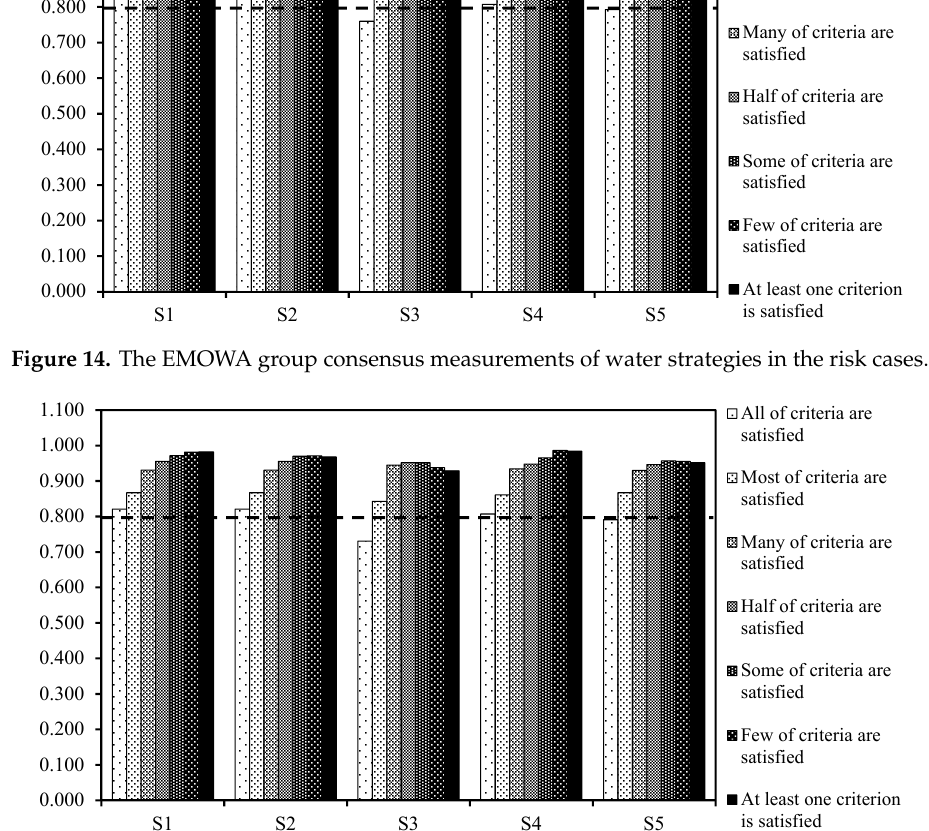
Figure 15. The IMOWA group consensus measurements of water strategies in the risk cases.